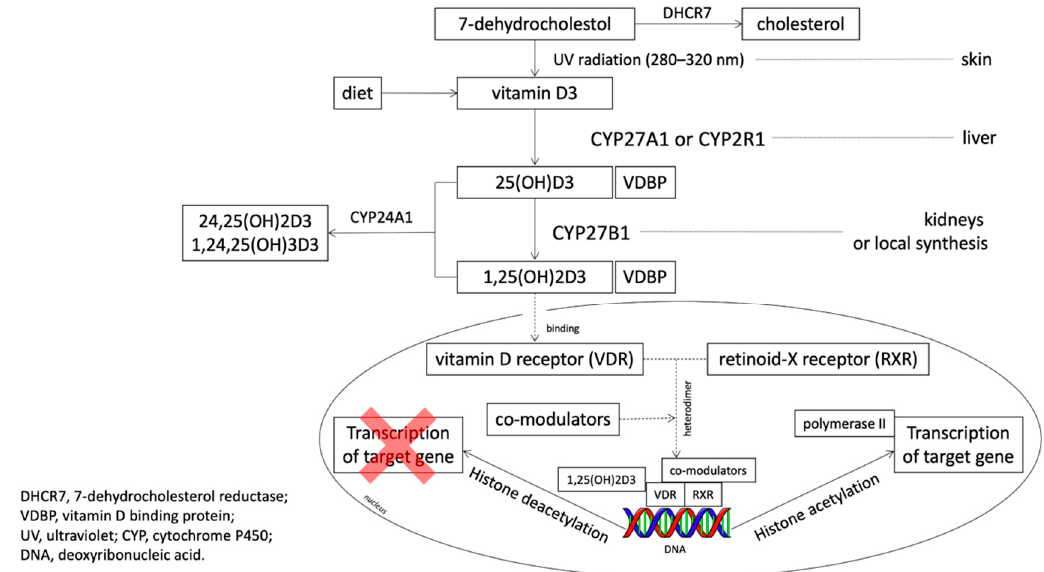
Figure 1. The metabolic pathway of vitamin D (based on Feldman et al., 2014 [4], Jekinson 2019 [13] and Dou et al., 2016 [14] with own modifications).